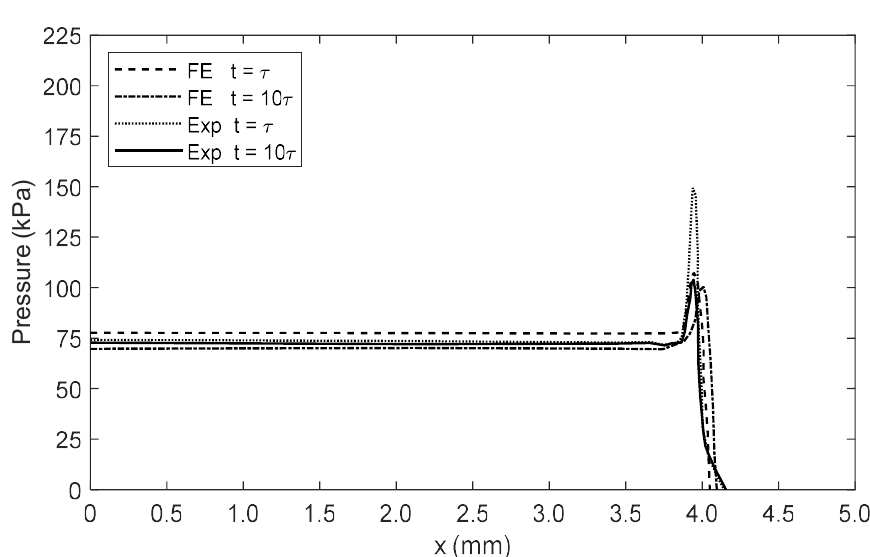
Figure 7. Predicted contact pressure distribution (normal load of 3.9 N).